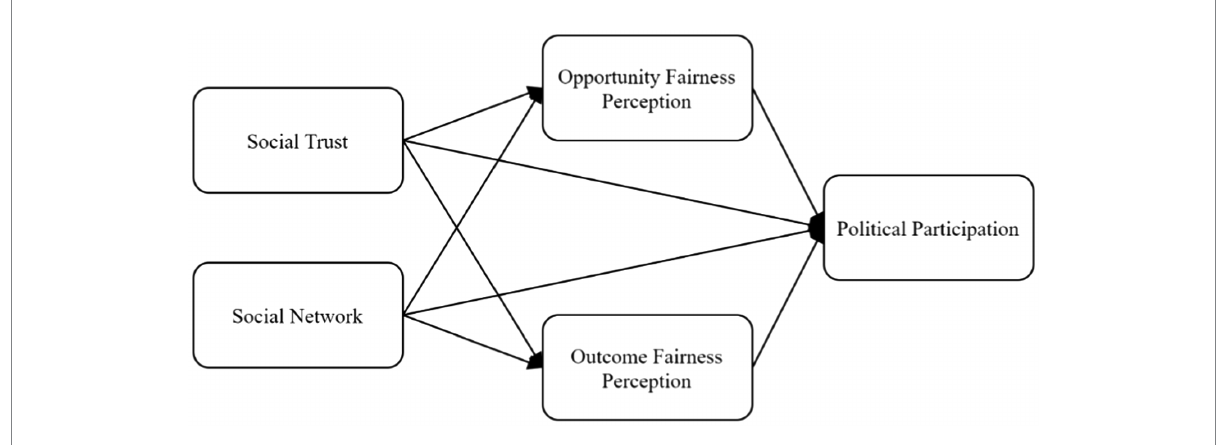
FIGURE 1 . The influence mechanism of farmers’ political participation.